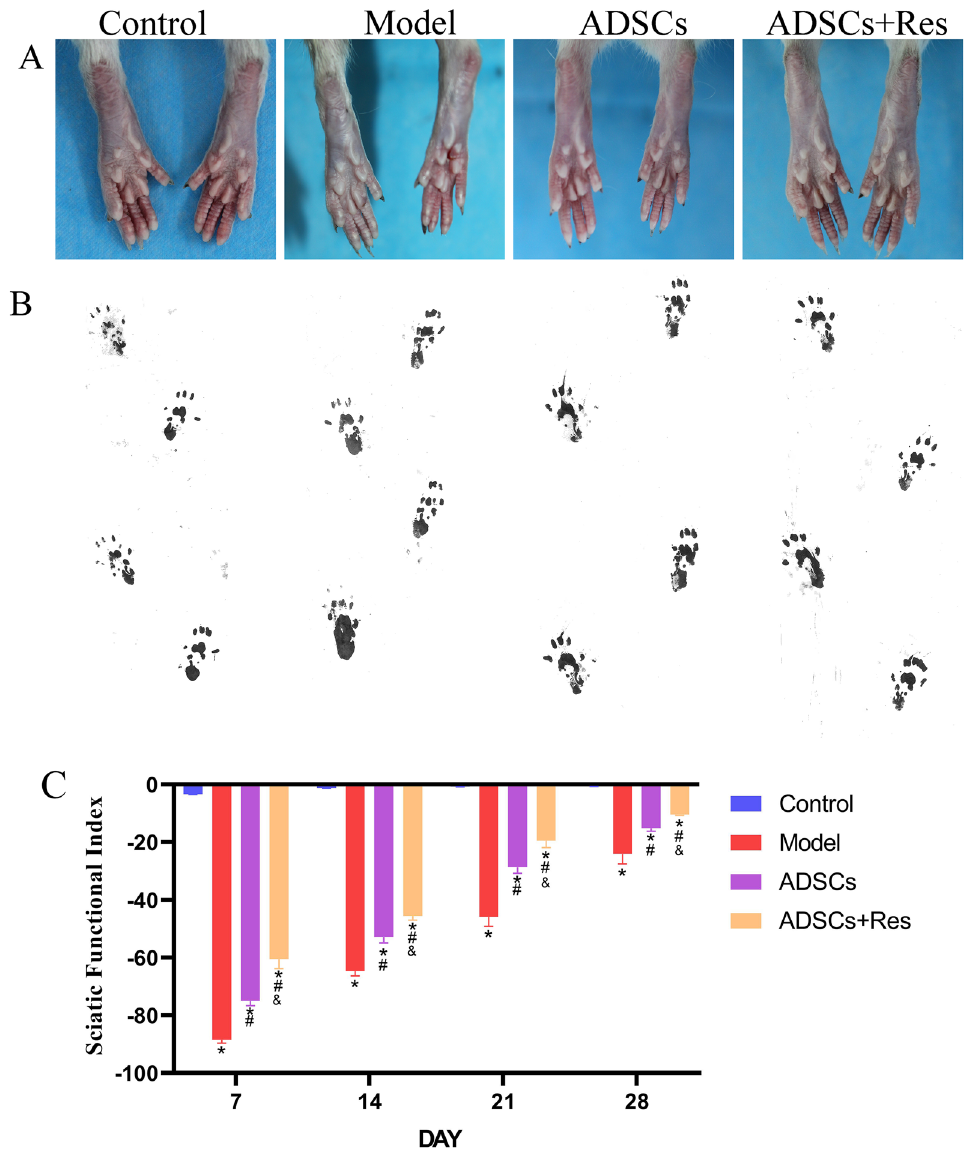
Figure 6. Effects of ADSCs pretreated with resveratrol on functional recovery after sciatic nerve injury. ( A ) Recovery of foot morphology; ( B ) Rat footprint; ( C ) SFI scores at different time points for the functional recovery from peripheral injury of the rats. *P < 0.05 compared with the control group, n = 5; #P < 0.05 compared with model group, n =